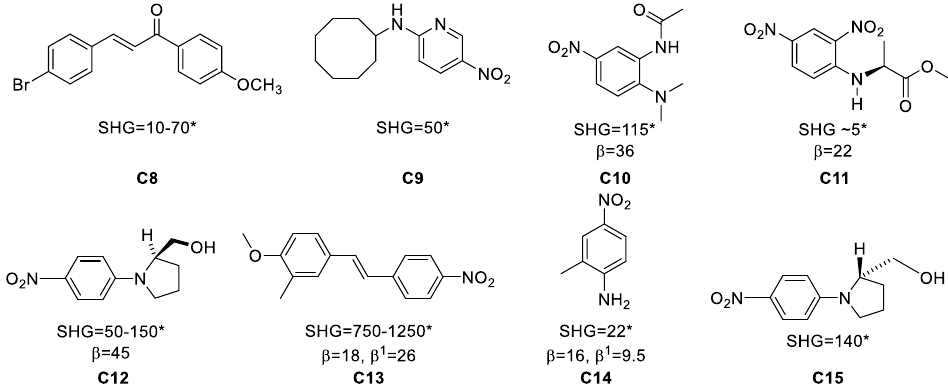
Figure 5. Examples of organic materials that have been studied as single crystals for frequency doubling. * Powder Second Harmonic Generation (SHG) vs. urea; β in ×10 −30 esu at 1.06 μm; β 1 : at 1.9